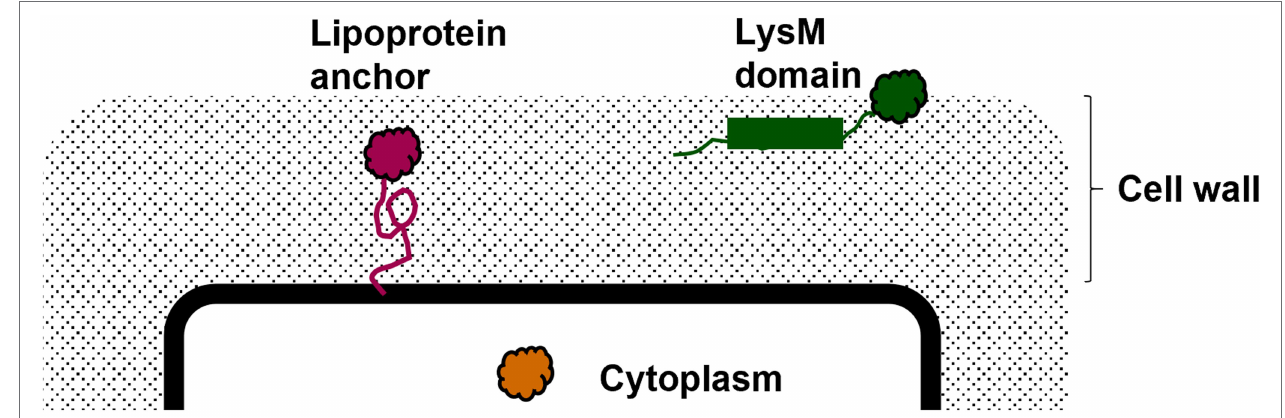
FIGURE 1 | A schematic presentation of the vaccine candidates with different levels of antigen exposure. The picture illustrates cytoplasmic localization of the antigen (orange), covalent anchoring of the antigen to the cell membrane through a lipoprotein (magenta) and non-covalent anchoring to the peptidoglycan cell wall through a LysM domain (green).